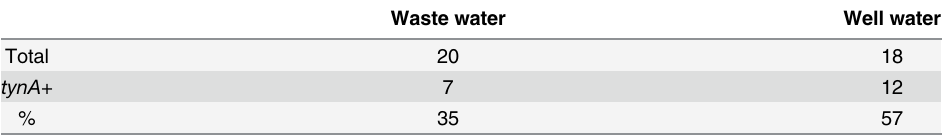
Table 1. Frequency of E . coli in environmental isolates. a